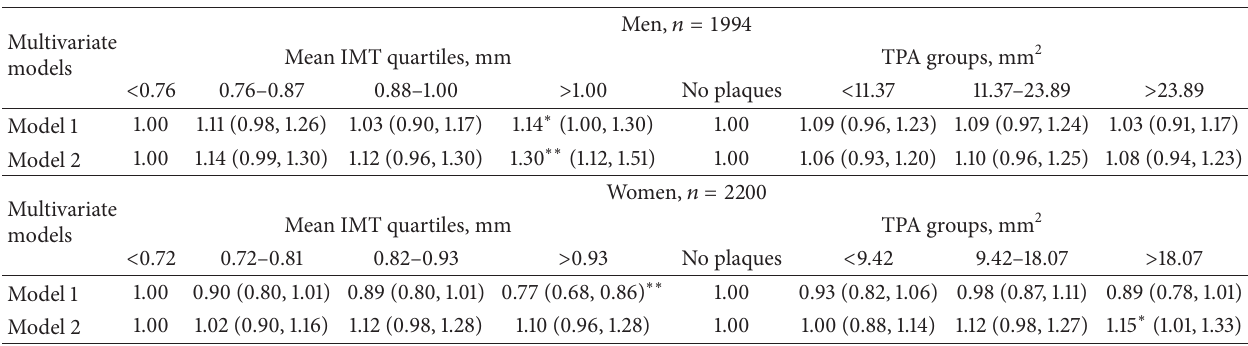
Model 1. Serum 25 (OH) D adjusted for season when vitamin D samples were obtained. Model 2. Serum 25 (OH) D adjusted for season of sampling, age, BMI, SBP, and total cholesterol. ∗